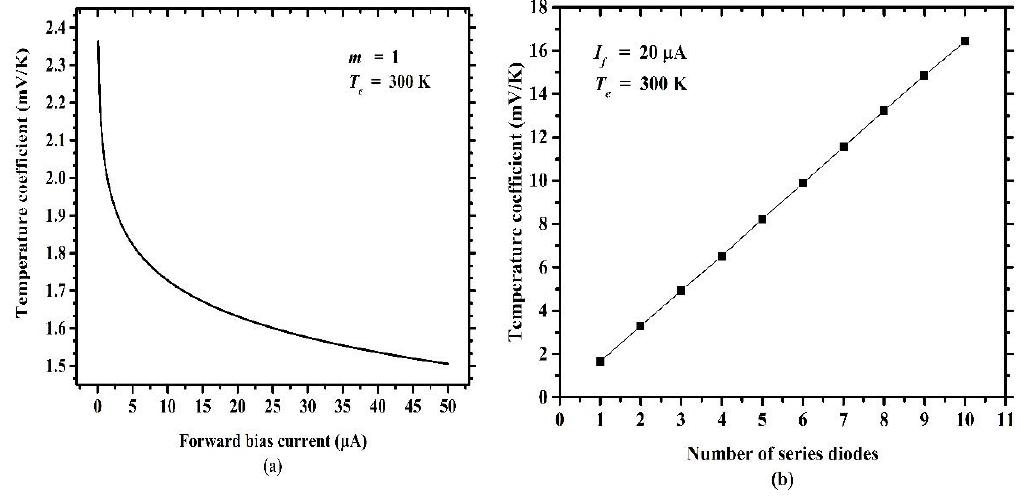
Figure 3. Temperature coefficient dependence on ( a ) forward bias current and ( b ) number of series diodes.